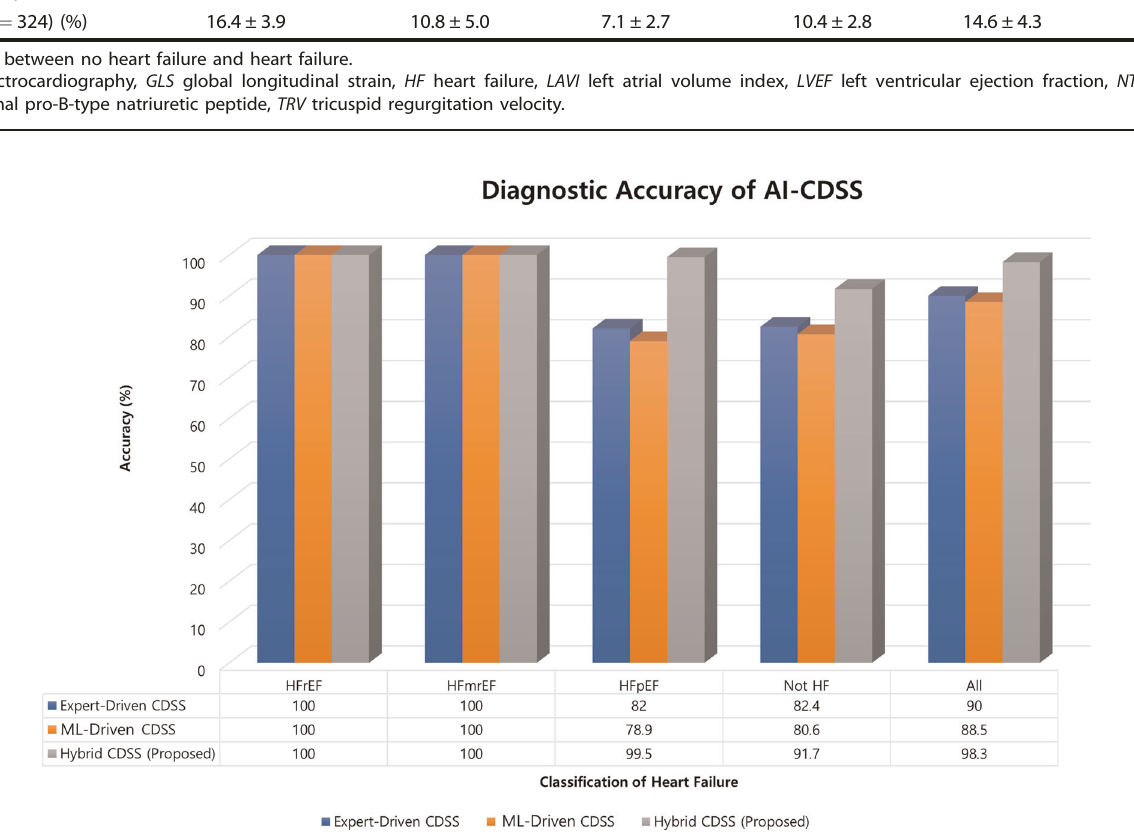
Fig. 2 Comparative analysis of the diagnostic accuracy of different approaches in the retrospective cohort. CDSS Clinical Decision Support System, HFmrEF heart failure with mid-range ejection fraction, HFpEF heart failure with preserved ejection fraction, HFrEF heart failure with reduced ejection